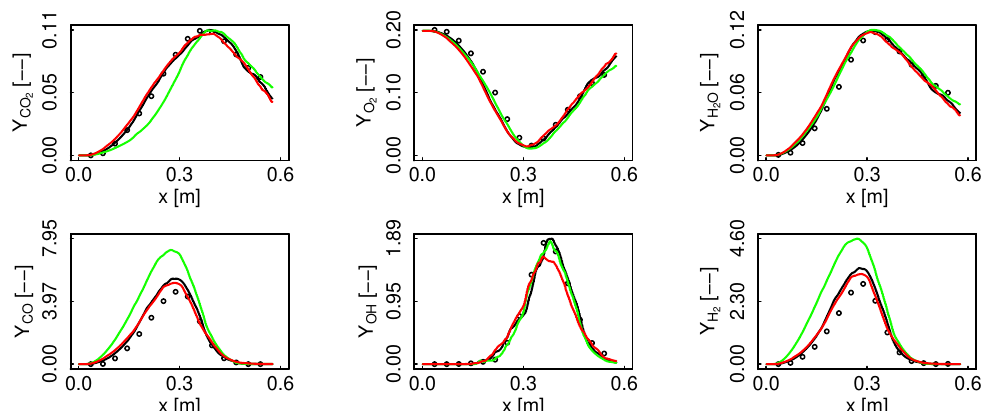
Figure 12. Species profiles comparison along the centerline for flame E. Black color represents non-premixed FTACLES, green color premixed FTACLES, red color FPV, and circles depict the experimental data.